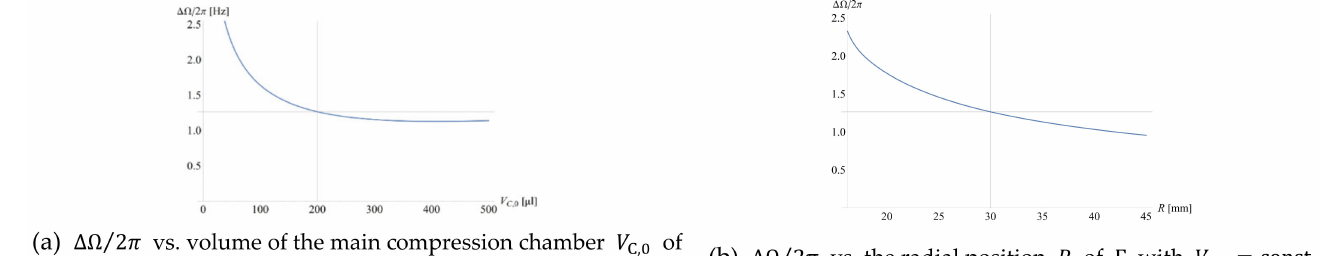
Figure 2. Standard deviation ∆Ω /2 π for CP-DF siphon valves (with default parameters, see Appendix A.1) as a function of ( a ) the volume of the main compression chamber V C,0 , and ( b ) the radial position R for typical dimensional (manufacturing) tolerances (see Appendix A.1). The dotted horizontal and vertical lines indicate the standard deviation of Ω and the volume of main compression chamber V C,0 in the default geometry and